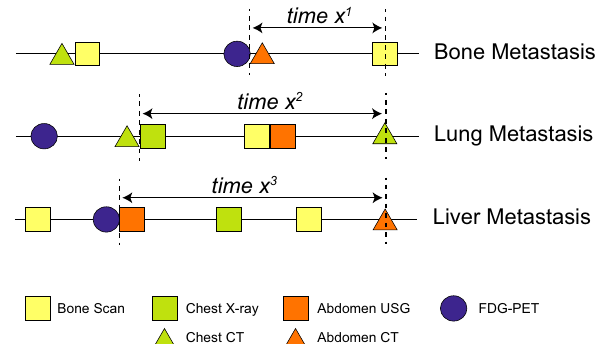
Figure 1. Definition of time intervals. We calculated the interval between the date of clinical diagnosis of metastasis and the date of previous imaging studies of target organs. For instance, for a patient with lung metastasis, as shown in this figure, the time interval (X 2 ) was defined as the date between chest CT at diagnosis of metastasis and previous chest radiography, not including abdominal USG and abdominal CT. 18 F-FDG-PET was allowed regardless of metastasis sites. The time intervals for patients with bone metastasis (X 1 ) and those with liver metastasis (X 3 ) were calculated with the same principles. USG, ultrasonography; CT,